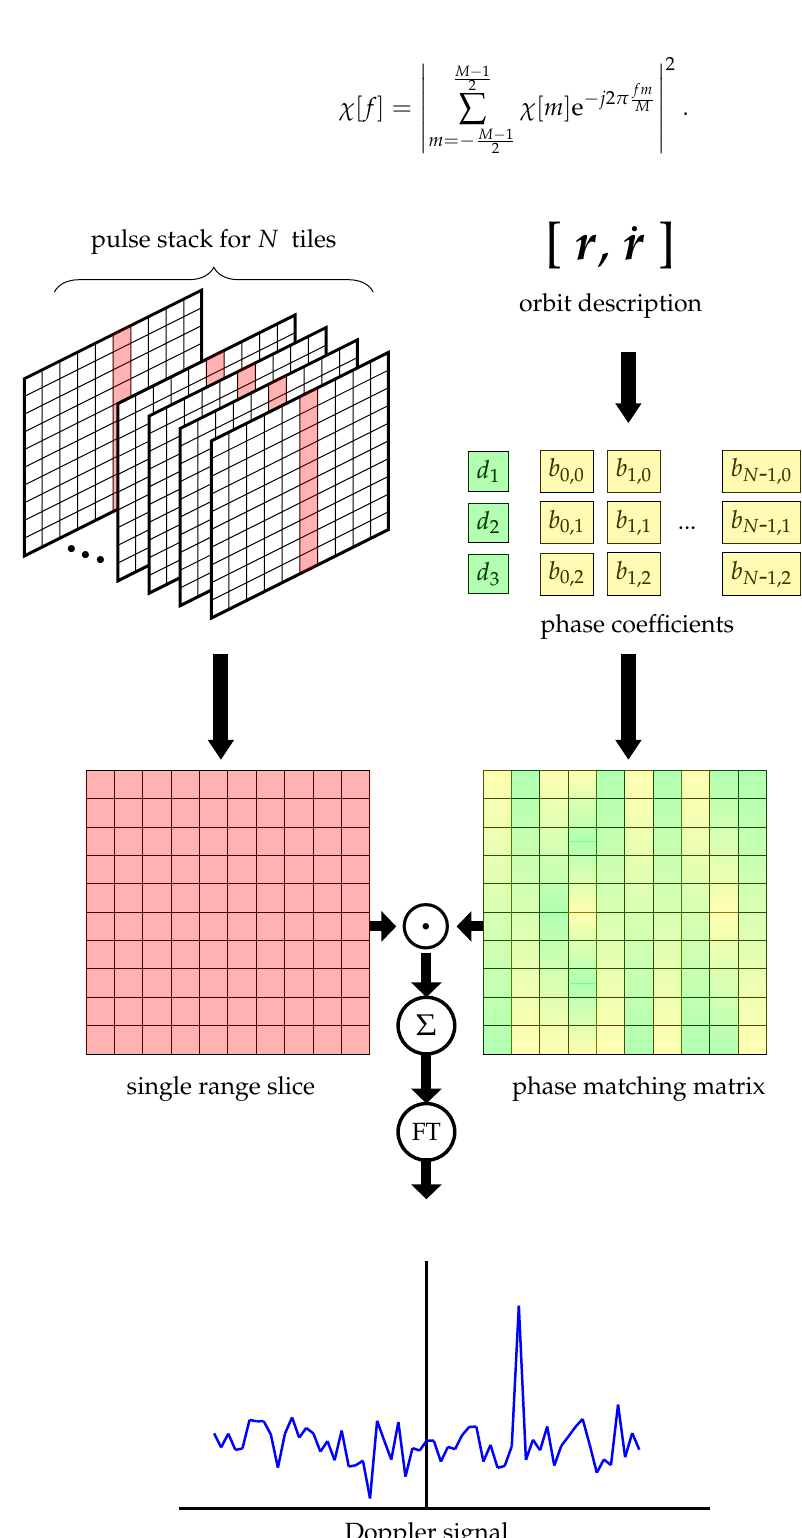
Figure 4. Illustration of the signal processing steps outlined in Section 3. An orbital state vector is used to determine the polynomial phase signal coefficients to form a phase-matching matrix. A single range’s slow-time signals are matched to the orbit, and combined using this matrix before